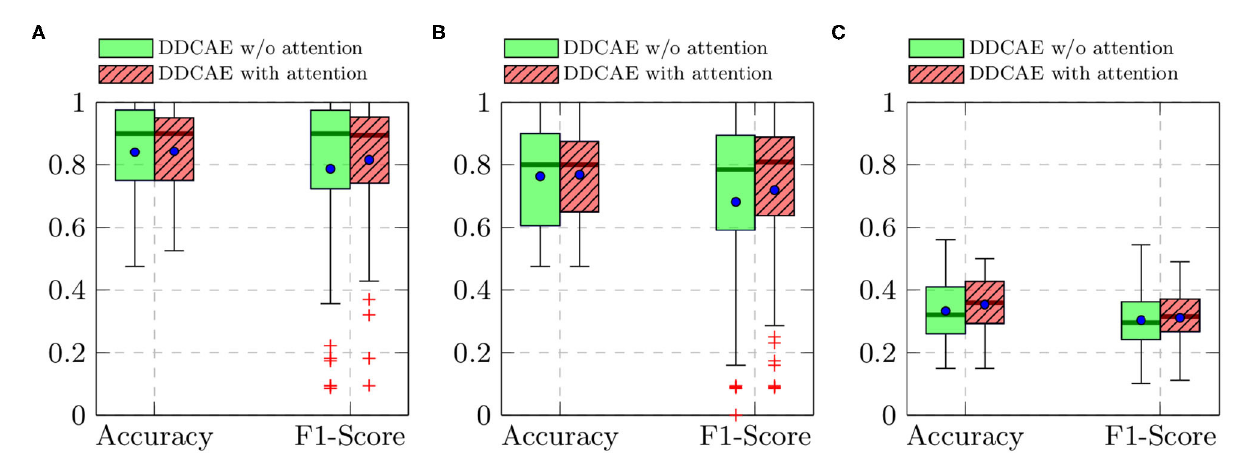
FIGURE 7 | BioVid Heat Pain Database (Part A): classification performance comparison in a Leave One Subject Out (LOSO) cross-validation evaluation setting. Within each box plot, the mean and the median classification performance are depicted respectively with a dot and a horizontal line. (A) T 0 vs . T 4 , (B) T 1 vs . T 4 , (C) 5 classes.